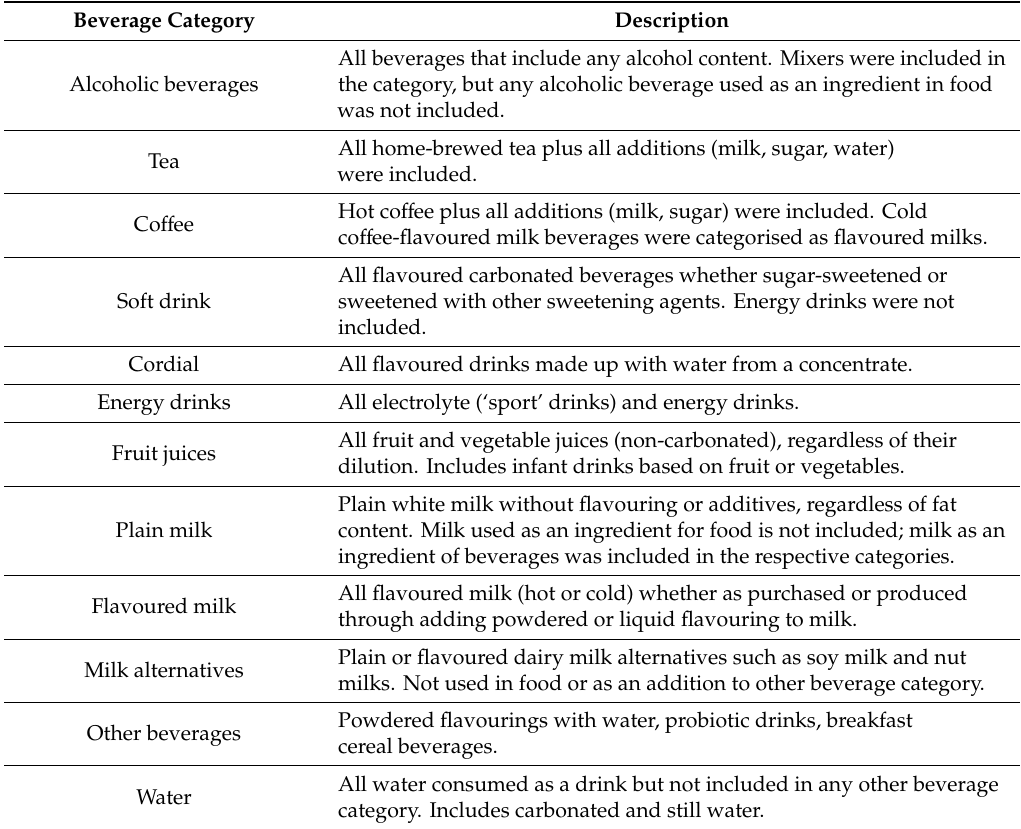
Table 1. Description of beverage category